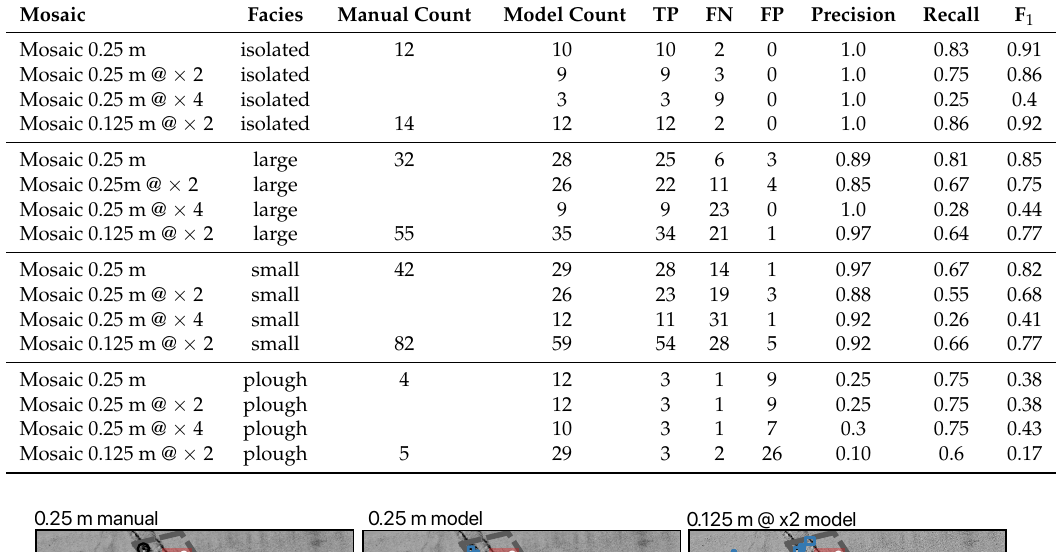
Table 2. Comparison of the automated boulder detection to the manual interpretation for the different facies and mosaics shown in Figures 7–10.